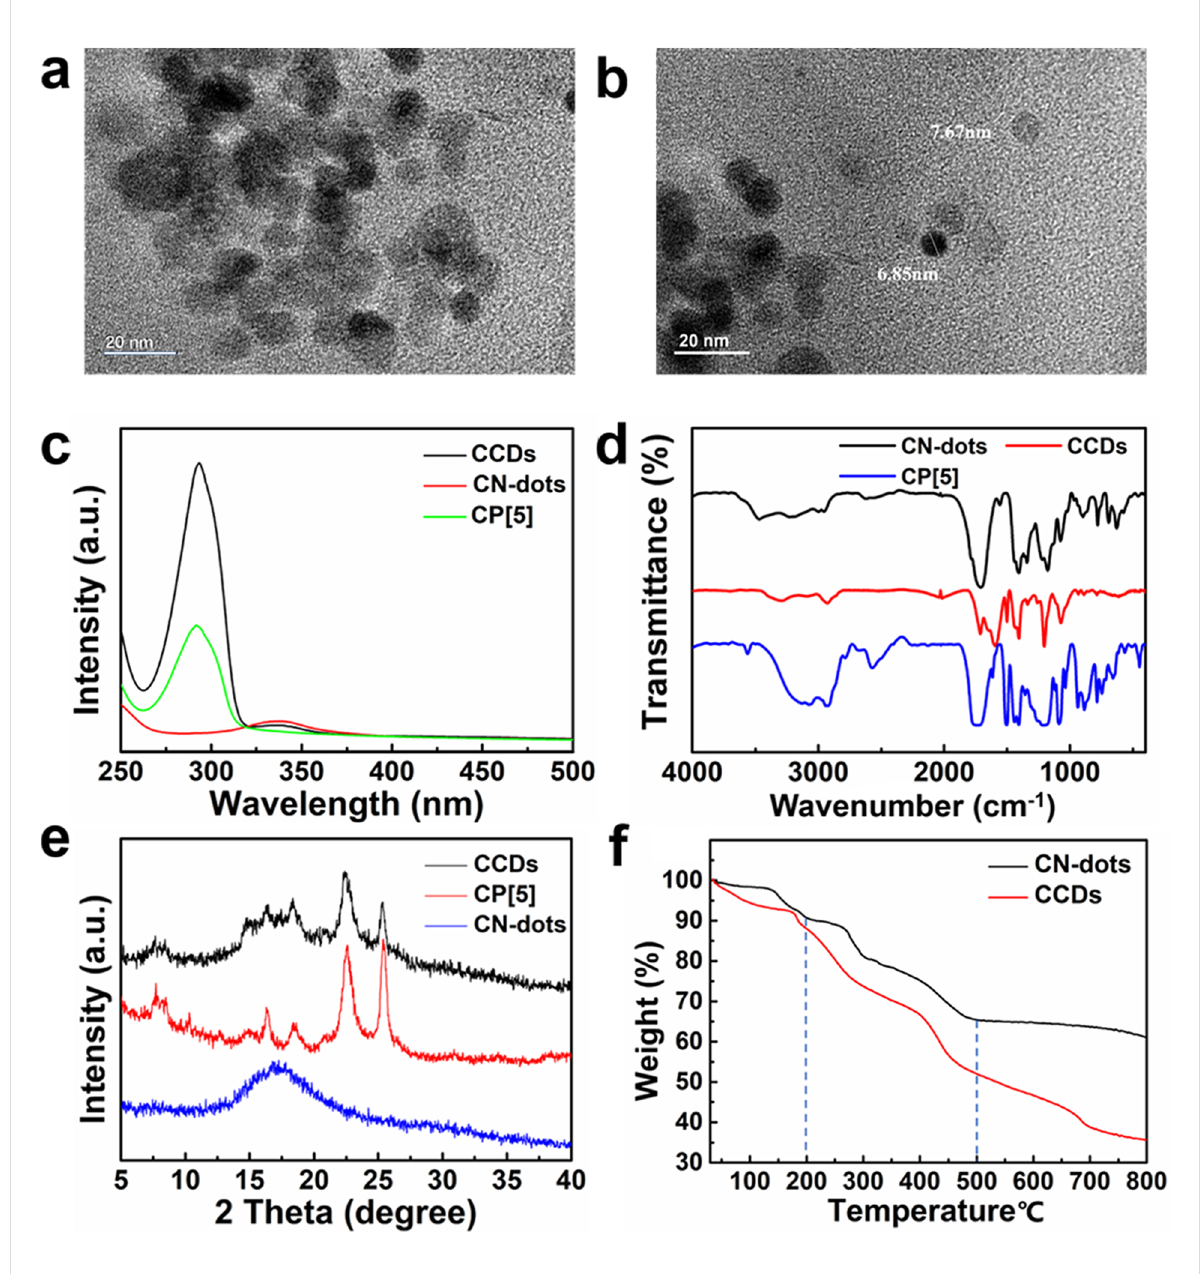
Figure 1: TEM images of a) CCDs and b) CN-dots. c) UV–vis spectra of CP5, CN-dots, and CCDs. d) FTIR spectra of CP5, CN-dots, and CCDs. e) PXRD patterns of CP5, CN-dots, and CCDs. f) TGA curves of CN-dots and CCDs.